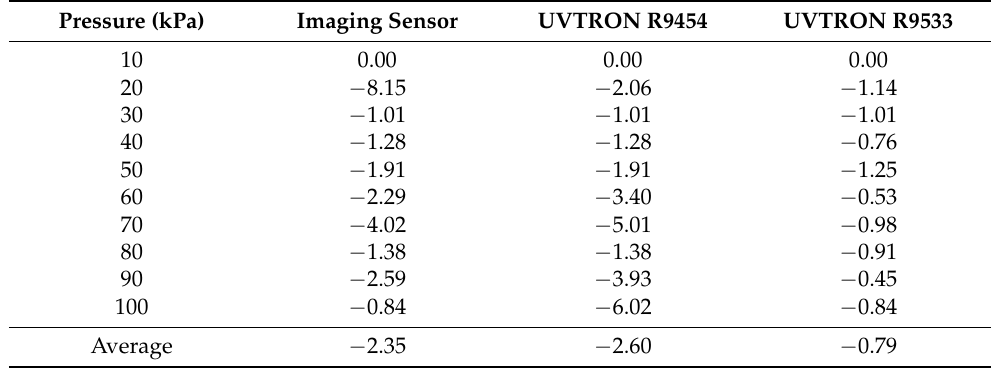
Table 4. CEV values percentage difference (%) of the different sensors with respect to the antenna (most sensitive sensor) using PTFE-insulated wire